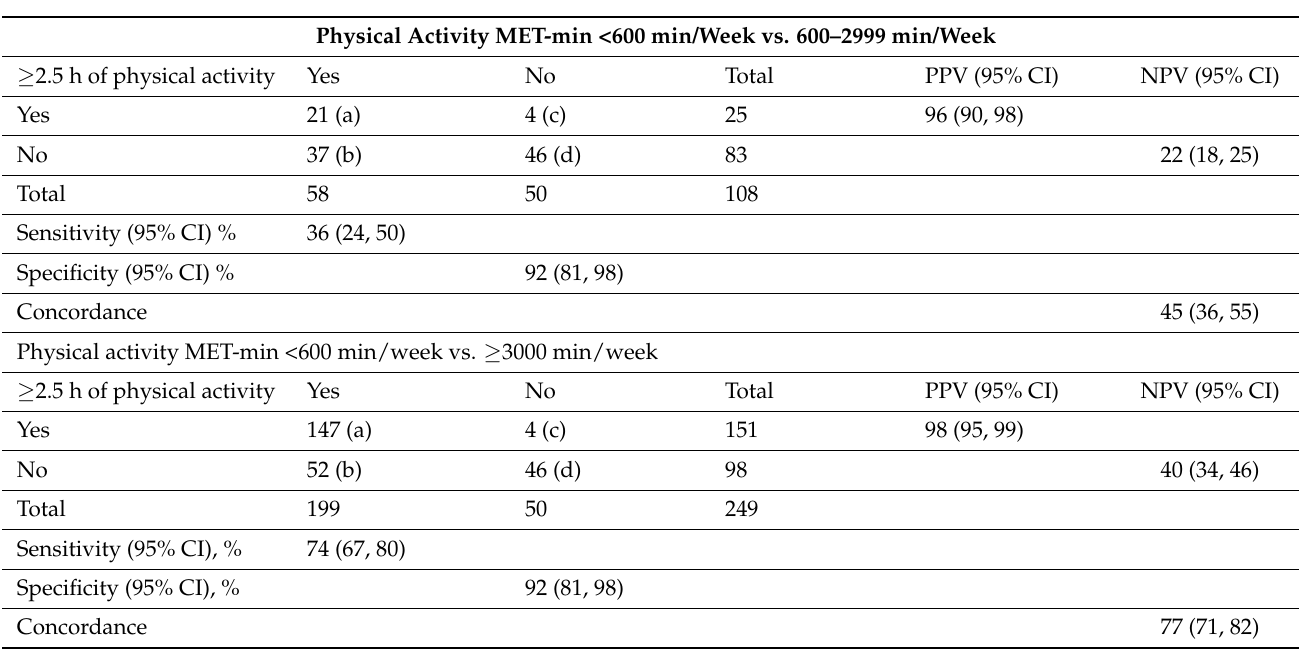
Figure 1. Sensitivity, specificity, positive predictive value (PPV), negative predictive value (NPV) and concordance in the total sample. Table 2. Confusion matrix, sensitivity, specificity, positive predictive and negative predictive values with 95% confidence interval for moderate and high physical activity